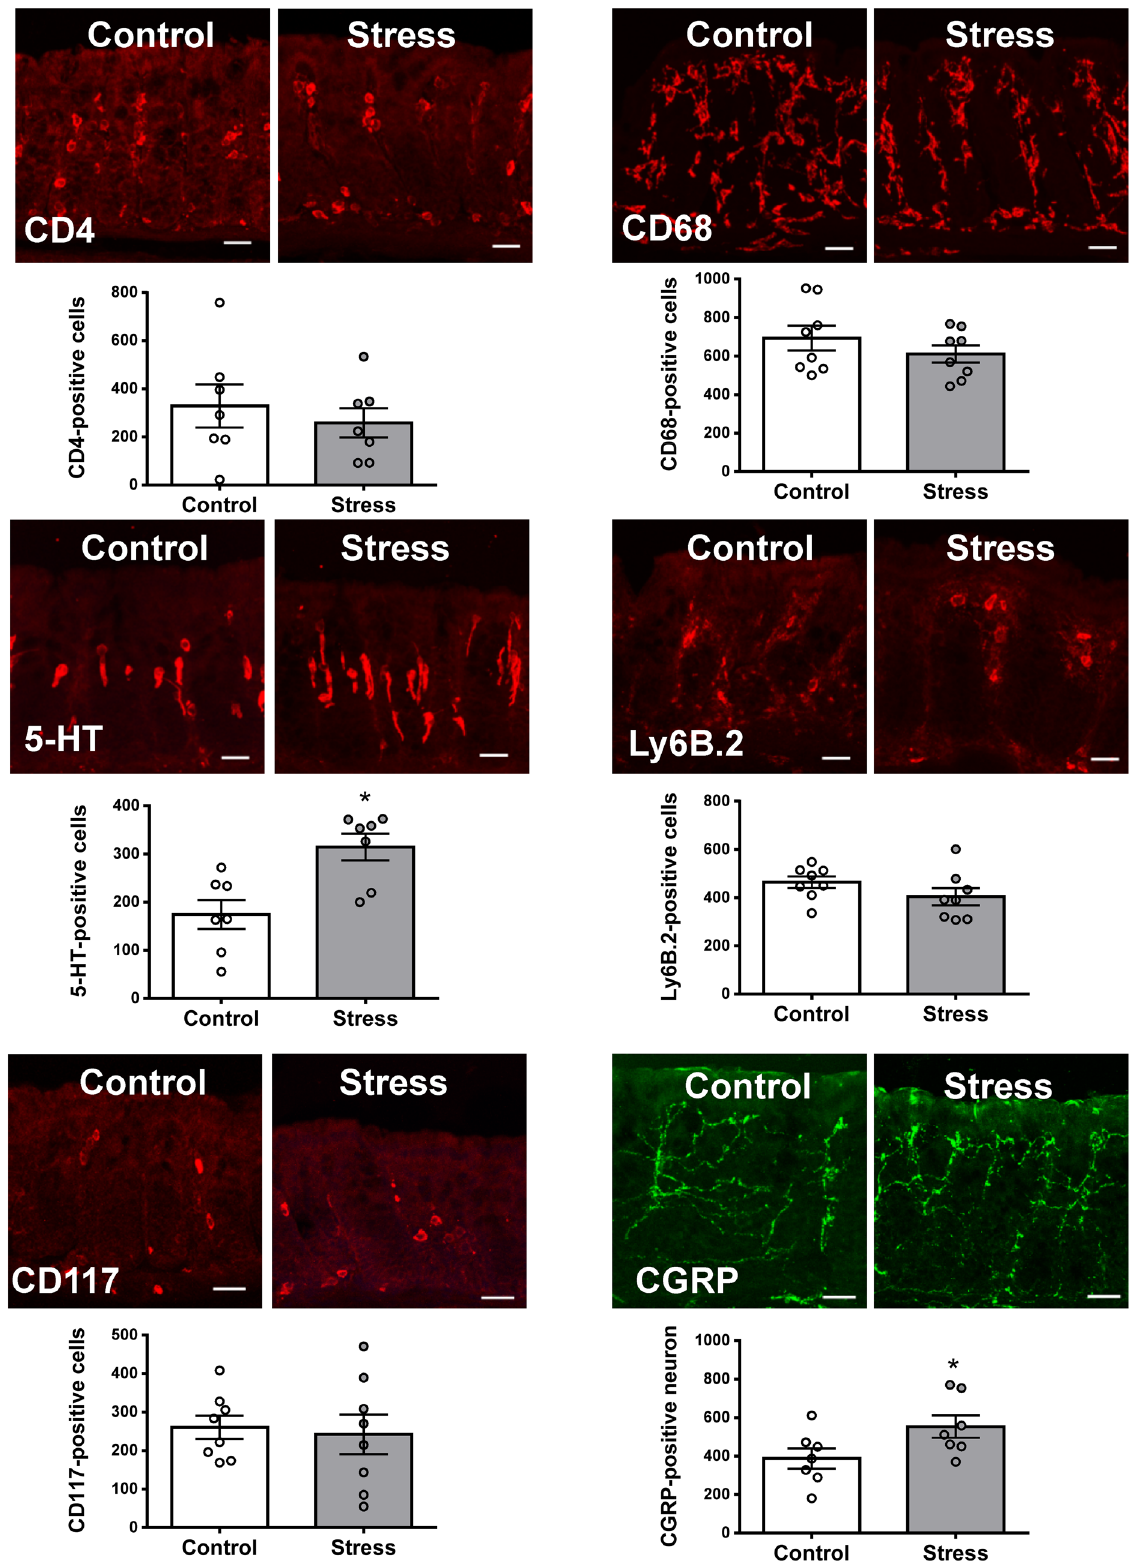
Figure 4. Juvenile SDS increased the number of 5-HT-positive cells and CGRP-positive neurons. Representative images of immunohistochemistry for CD4-, CD68-, 5-HT-, Ly6B.2-, and CD117-positive cells and CGRP- positive neurons in the colonic mucosa of control and stress mice. The number of CD4-, CD68-, 5-HT-, Ly6B.2-, and CD117-positive cells, and CGRP-positive neurons per 10 6 μm 2 were counted. Data are presented as the mean ± SEM (n = 7, 8 mice per group). * p < 0.05 compared with the control group. Scale bars, 50